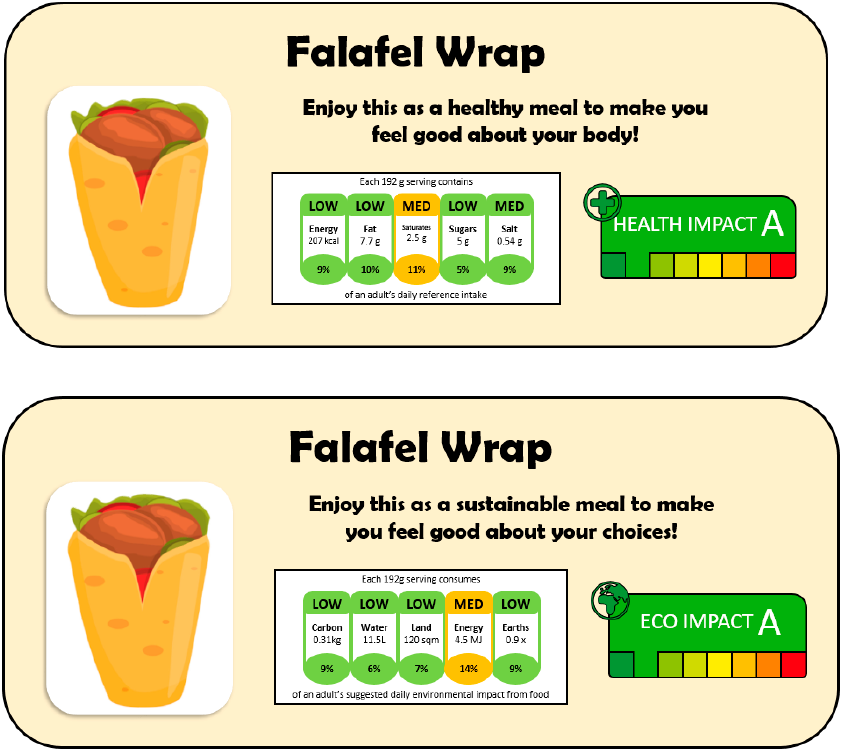
Figure 1. Example product label in the health ( top ) and environment ( bottom ) condition. Green impact ratings imply that the product is better for health/the environment.